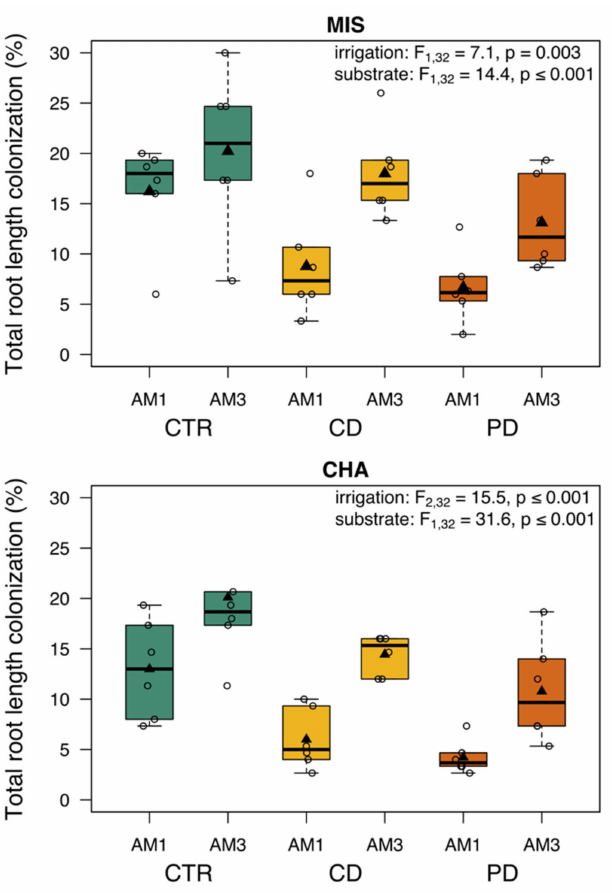
Figure 2. Total root length colonization of roots from two wheat cultivars [ Triticum aestivum ; Chamsin (CHA), Mistral (MIS)] 67 days post sowing. Cultivation occurred under different irrigation conditions [control (CTR), continuous drought (CD) and pulsed drought (PD), factor: irrigation]. Plants were either mycorrhized with a single fungus (AM1; Rhizoglomus irregulare ) or with a mixture of three fungi (AM3; R. irregulare , Funneliformis mosseae , F. caledonium ) (factor: substrate). Data are given as box–whisker plots with interquartile ranges (IQR; boxes) including medians (horizontal lines), means (triangles) and whiskers (extending to the most extreme data points with maximum 1.5 times the IQR); raw data are given as open circles. The results of linear models are shown comprising the remaining significant terms after model simplification; n =